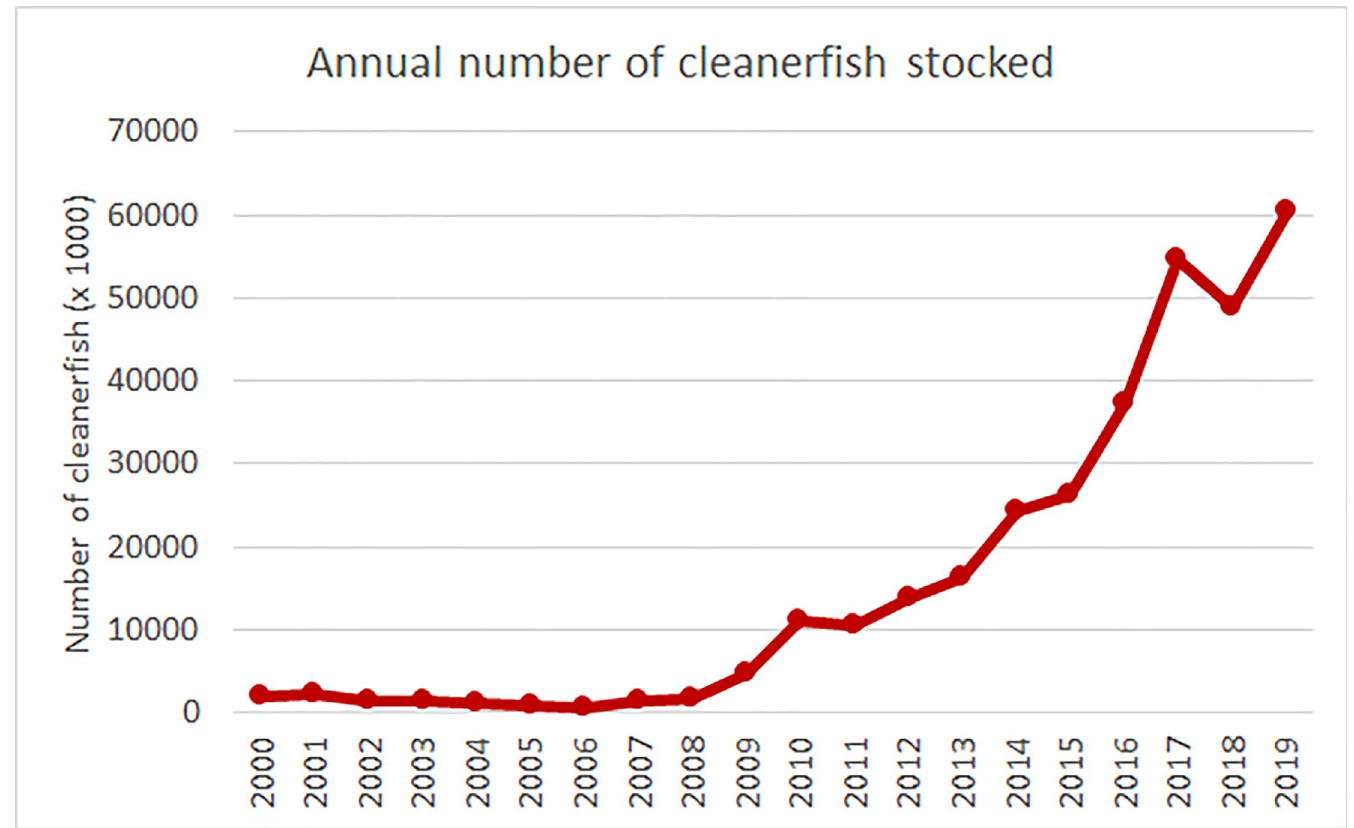
Fig 5. Cleanerfish deployment per year. Annual number of individual cleanerfish (in 1000) deployed in Norwegian aquaculture [21].